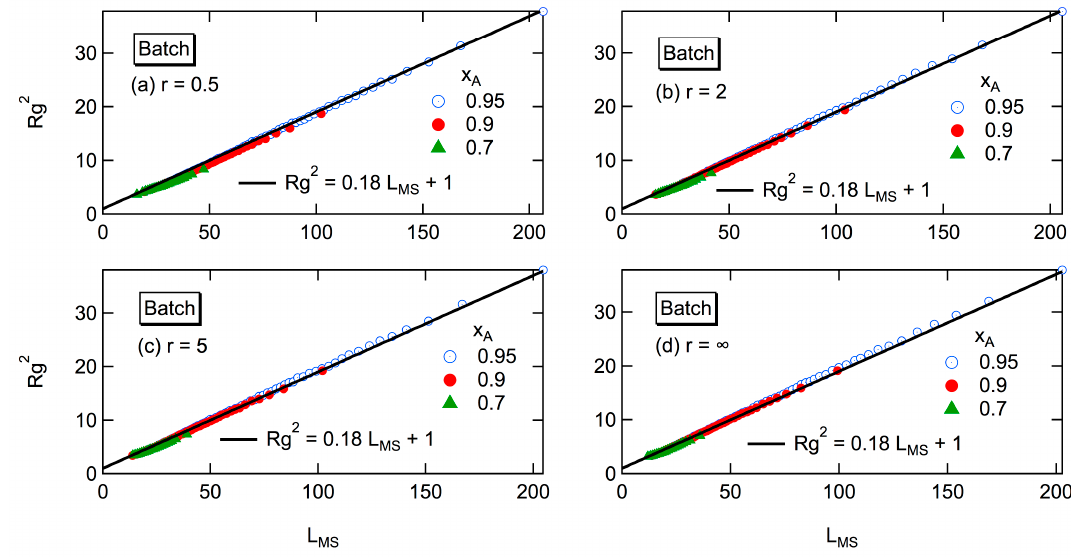
Figure 19. Universal relationship between Rg 2 and L MS for batch polymerization with various combinations of r and x A . ( a ) r = 0.5, ( b ) r = 2, ( c ) r = 5, and ( d ) r = ∞ .